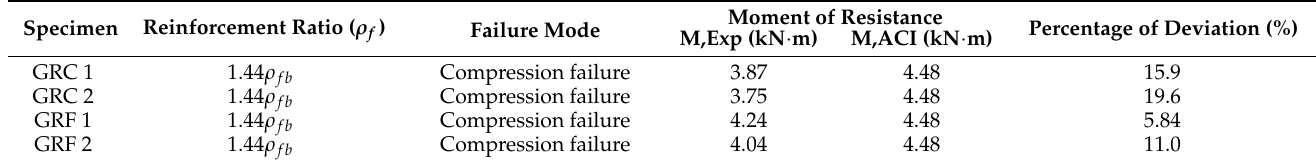
Table 7. Comparison of the moment of resistance for slabs reinforced with GFRP rods.